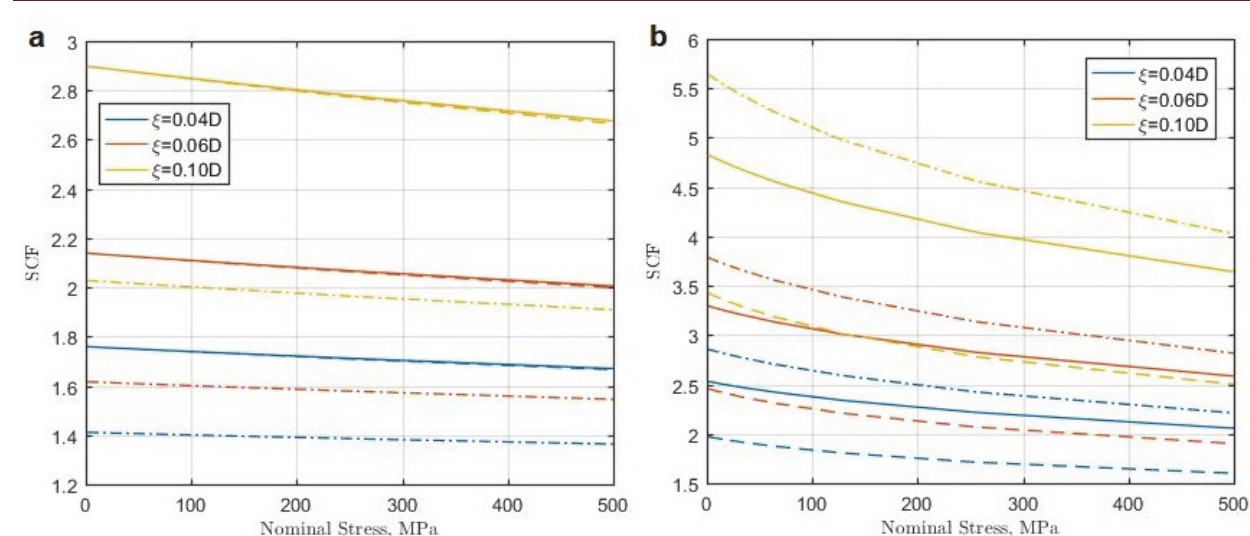
Figure 4: Effect of initial stress: a) Axial force loading, b) Internal pressure loading; R=400mm, h =10mm: